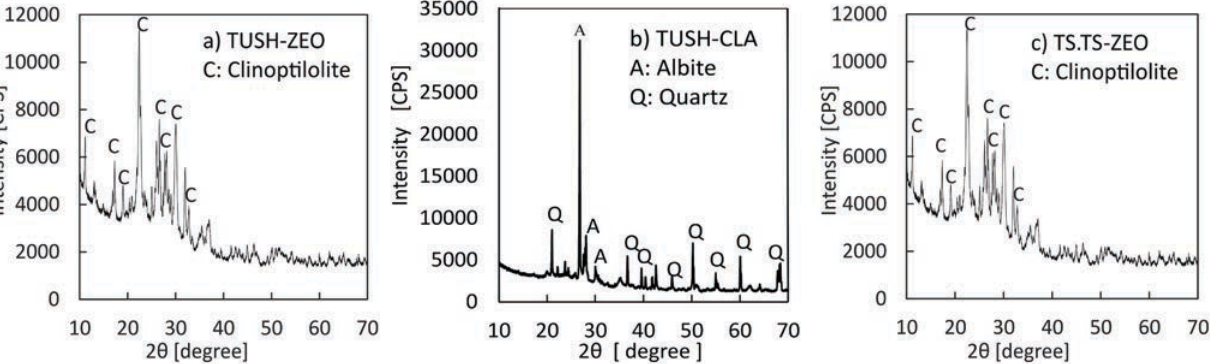
Fig. 1. XRD patterns of Mongolian natural minerals of (a) TUSH-ZEO; (b) TUSH-CLA and (c) TS.TS-ZEO